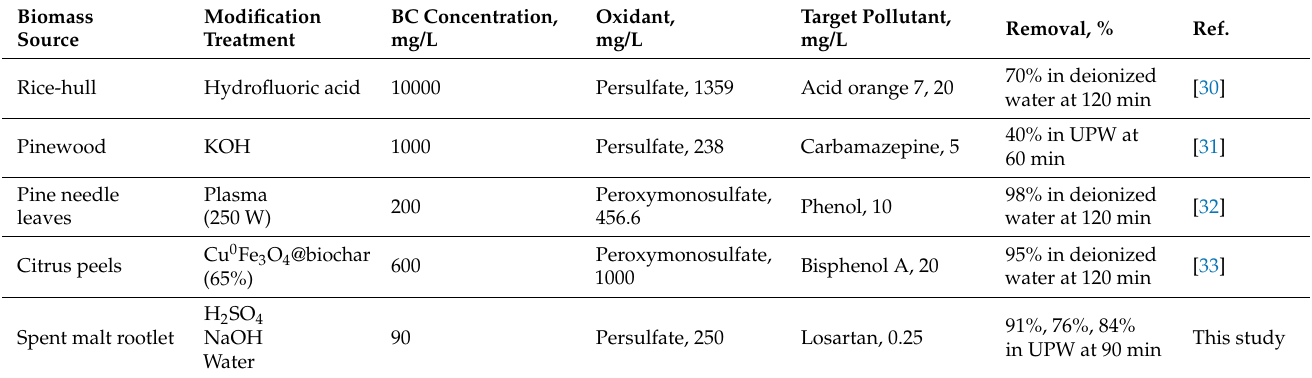
Table 3. Application of modified biochars for sulfate-radical activation for various pollutant decom-